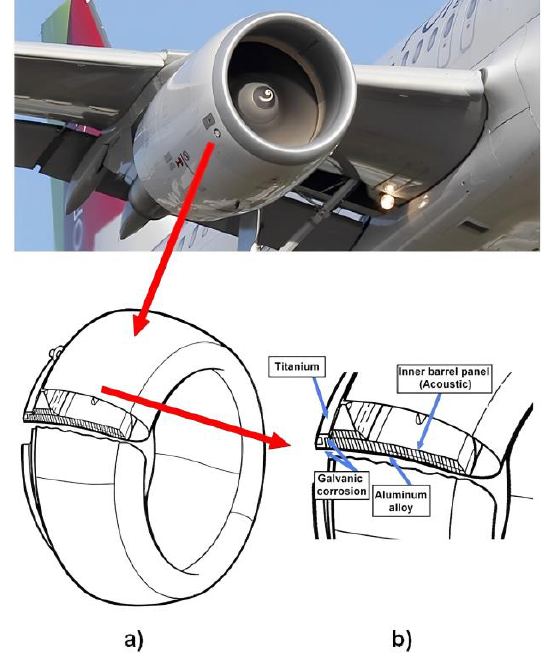
Figure 3. A320 intake ( a ) geometry and assembly ( b ) inner barrel panel.